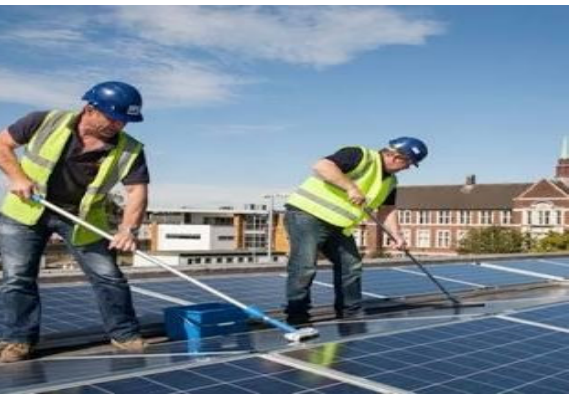
Figure 19. Manual cleaning of PV modules on the building rooftop [60].